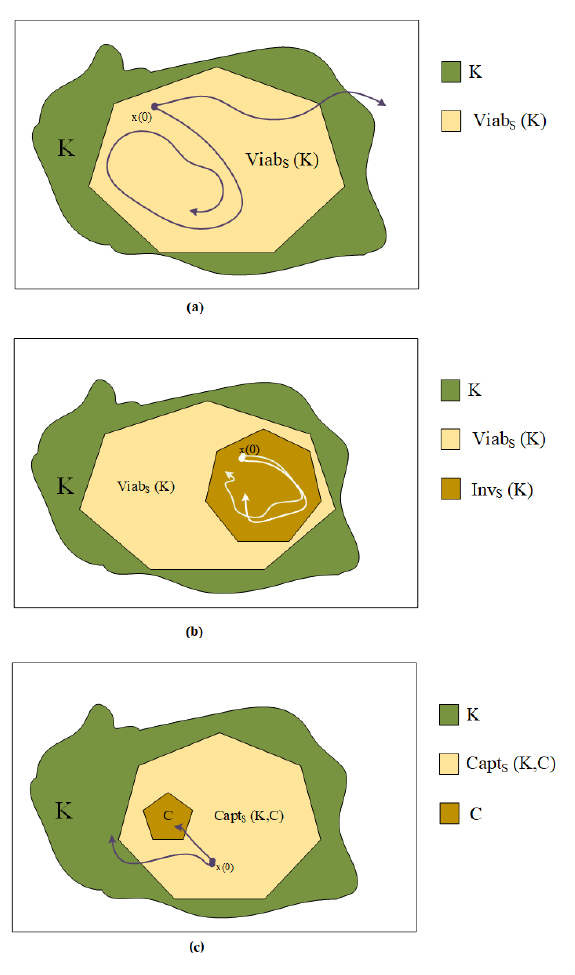
Figure 1. Conceptual representation of: ( a ) viability kernel ( b ) invariance kernel ( c ) capture basin (Adapted from